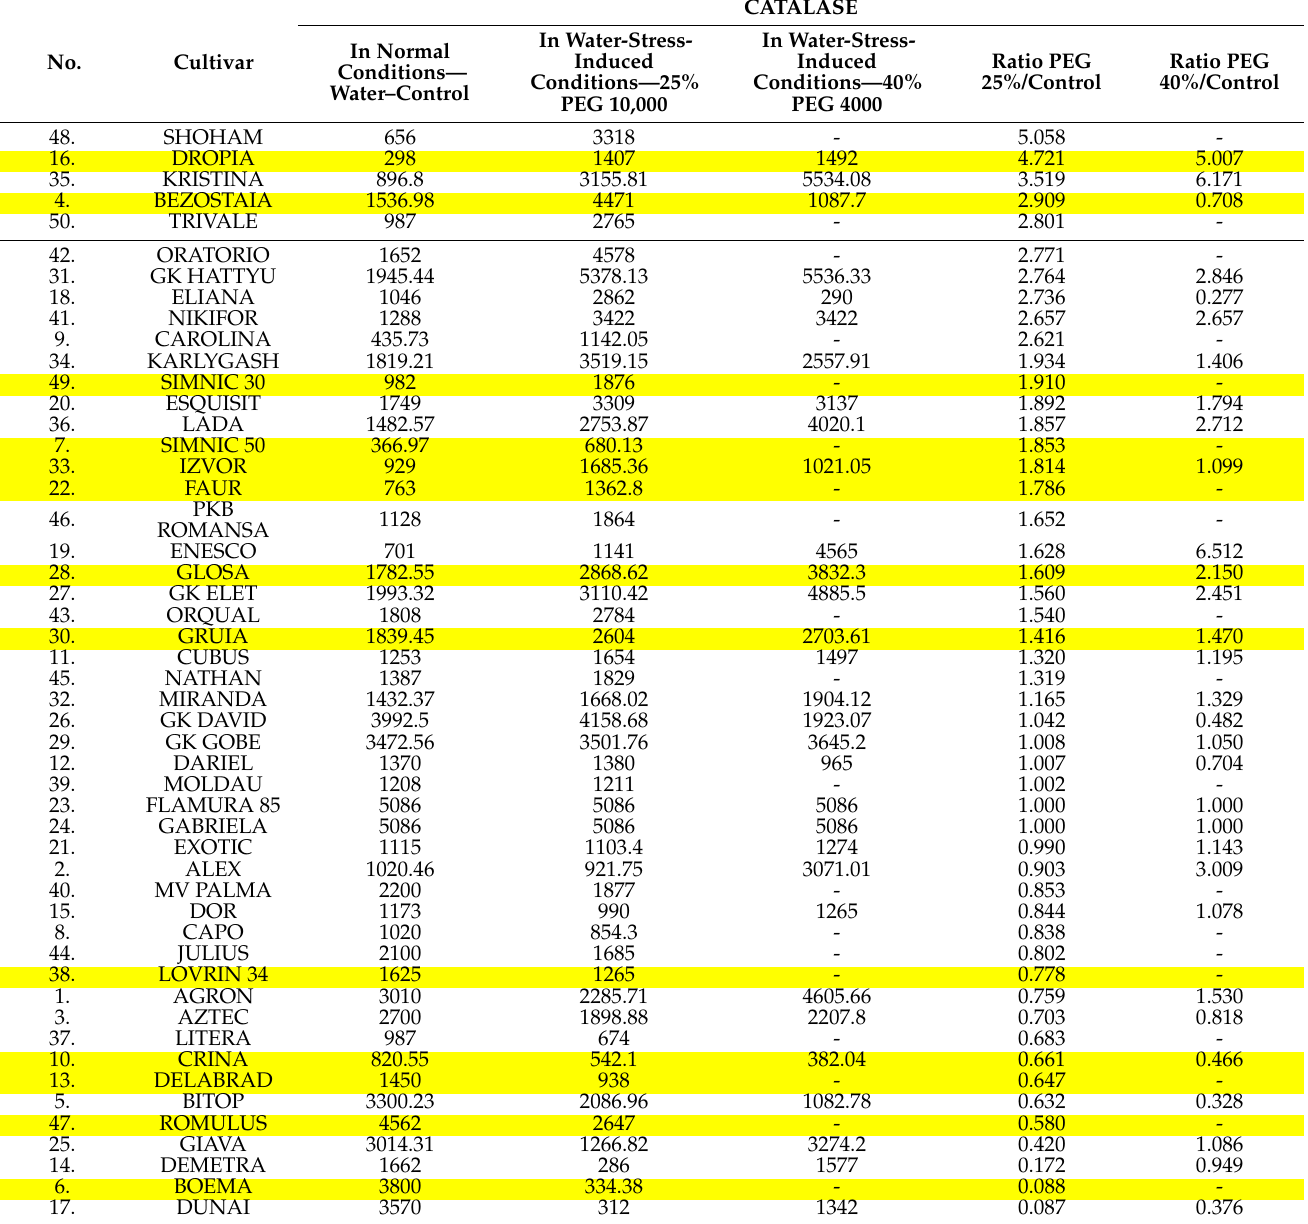
Table 3. The activity of catalase in an assortment of 50 wheat